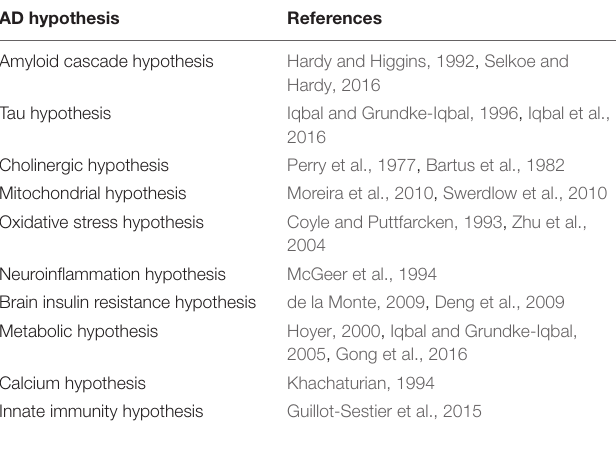
TABLE 1 | Examples of hypotheses proposed for